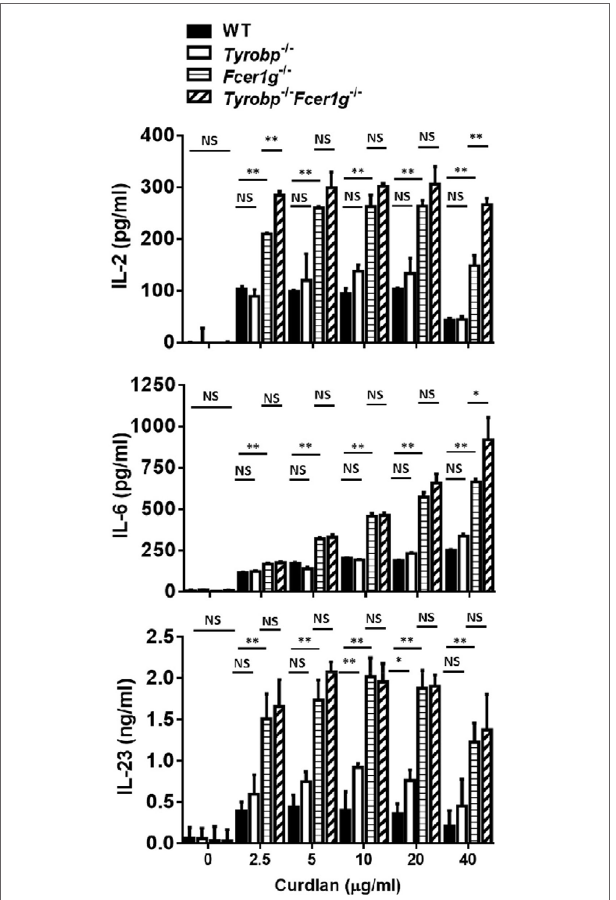
FigUre 2 | Increase of cytokine production by Fcer1g − / − and Tyrobp − / − Fcer1g − / − DCs after Dectin-1 activation. Six-day-cultured BMDCs derived from WT, Tyrobp − / − , Fcer1g − / − , and Tyrobp − / − Fcer1g − / − mice were harvested and then incubated with curdlan at indicated concentrations for 16 h. The supernatants were collected and secreted cytokines were measured by IL-2, IL-6, and IL-23 ELISAs. Error bars indicated mean + SD of three independent experiments. The significances * p < 0.05, ** p < 0.01, NS, not significant (Student’s t -test) were obtained by comparing Fcer1g − / − to Tyrobp − / − Fcer1g − / − DCs (upper rows), Fcer1g − / − to WT DCs (middle rows), and Tyrobp − / − to WT DCs (lower rows) as indicated. Data shown are representative from three separated